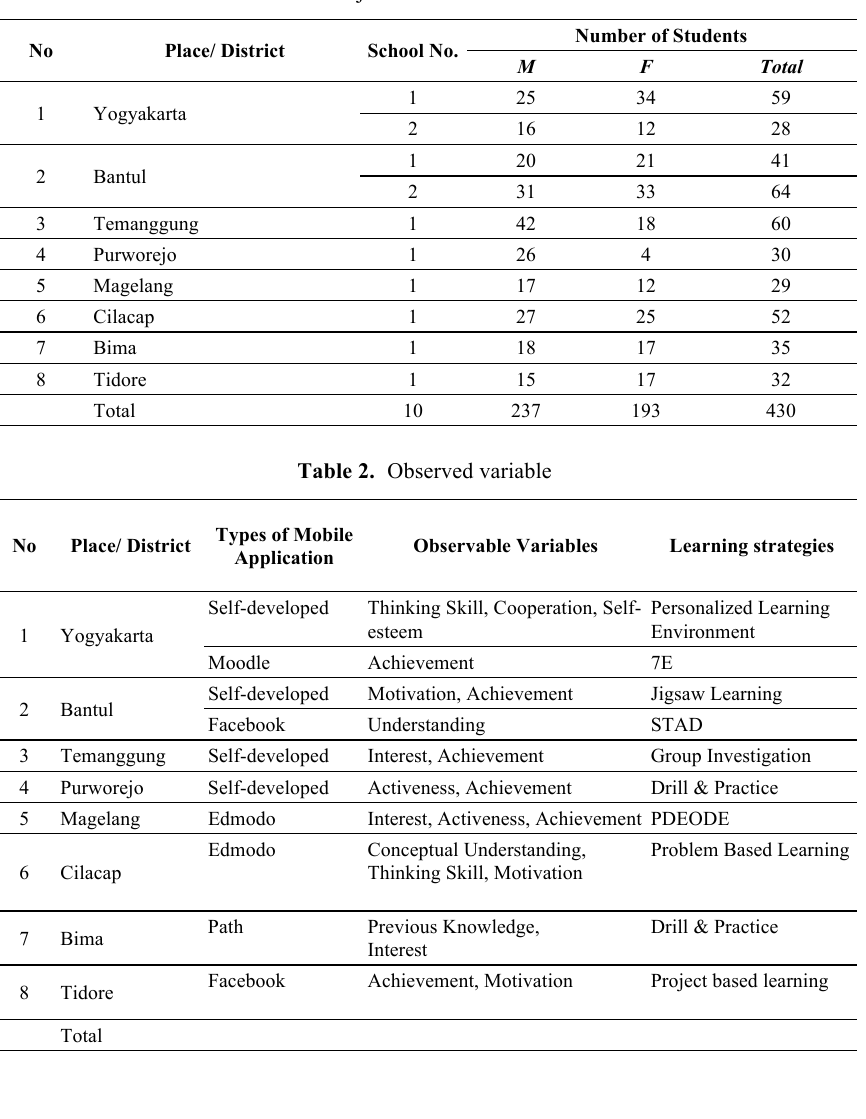
Table 1. Subject Number for each district